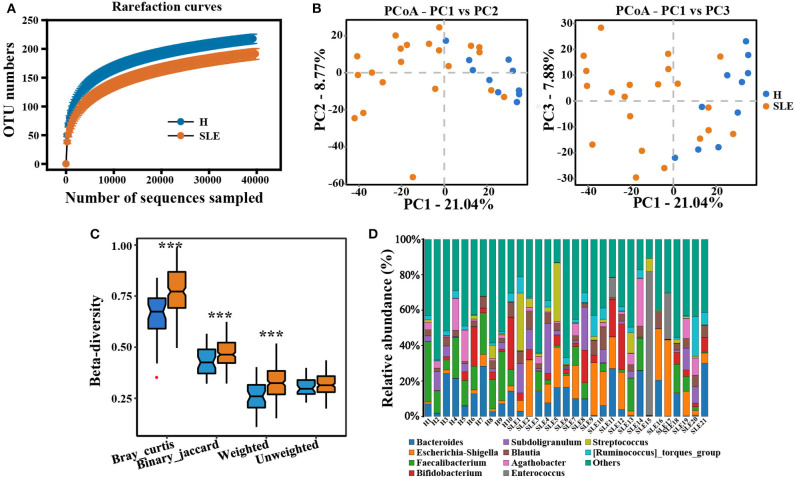
Altered gut microbiota diversity in SLE patients. (A) Rarefaction curve based on OUT count in healthy controls and SLE patients. H, healthy people (orange); SLE, SLE patients (blue). (B) The PCoA ordination of Bray-Curtis distances between SLE patients and healthy controls from 16S rDNA sequencing data. The first three axes of PCoA showed a clear separation. Left, PCoA (PC1-PC2); Right, PCoA (PC1-PC3). (C) Beta diversity index calculated by bray_curtis distance, binary_jaccard distance, weighted distance and unweighted distance. Student's t-test or rank-sum test. ***p < 0.001. (D) The relative abundance of dominant taxa at genus level in each sample.